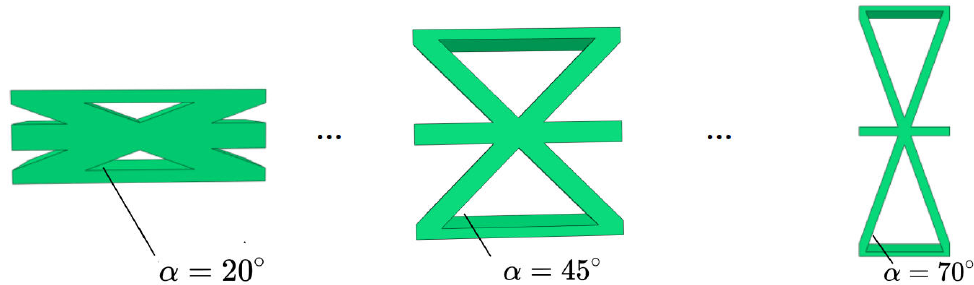
Figure 5. Geometric configurations of core cells with different included angles.